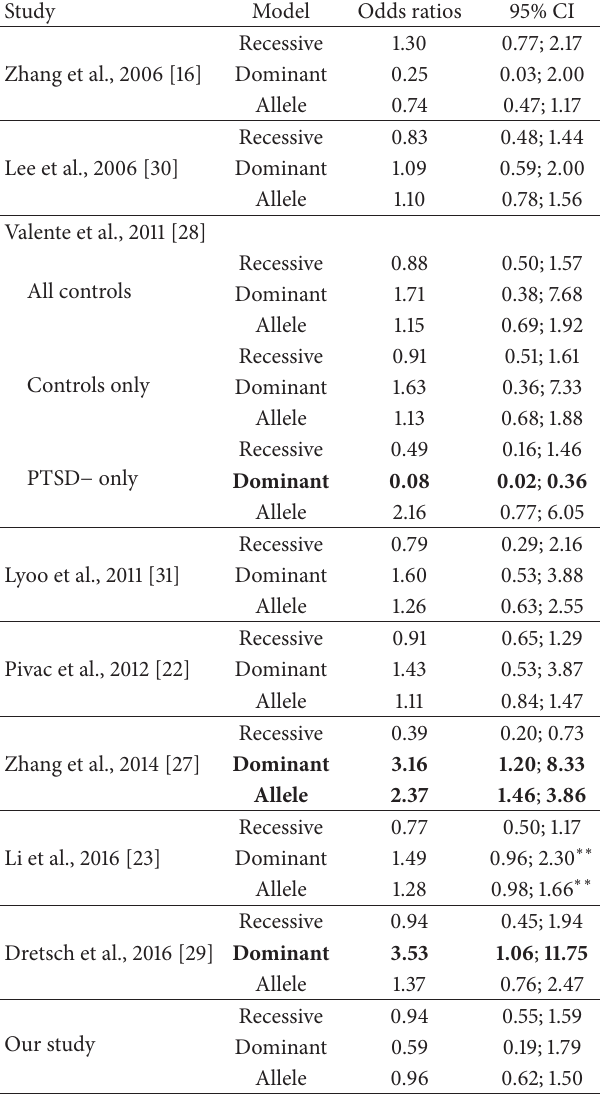
Table 5: Individual studies, their odds ratios, and 95% confidence intervals for recessive and dominant models on a genotype basis and on an allele